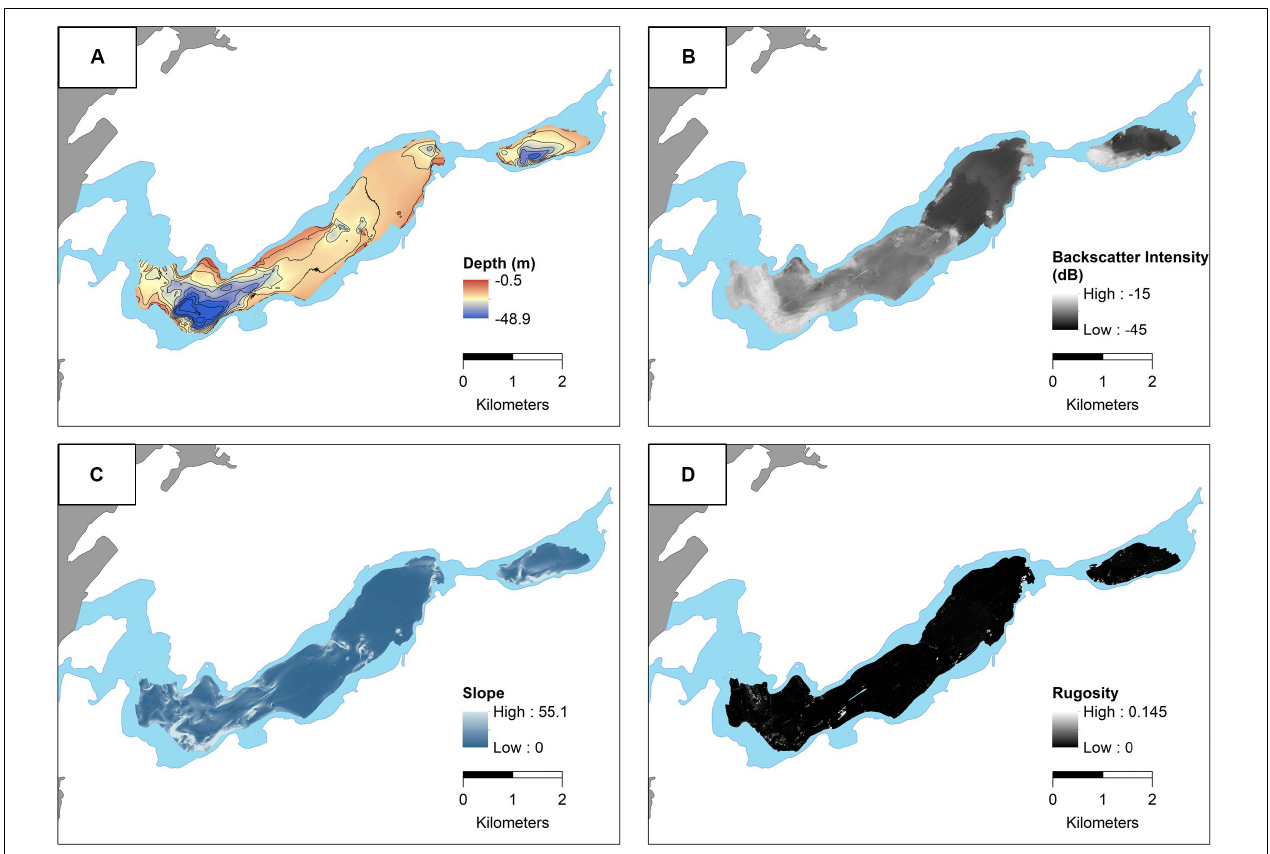
FIGURE 2 | Results from the 2017 Kongsberg EM3002D MBES survey of Loch Creran showing (A) bathymetry data (corrected to Lowest Astronomical Tide), and (B) backscatter intensity (dB); (C) slope and (D) rugosity were derived from the bathymetry data during data processing. The rasters shown have been merged and resampled to 2 m resolution. Prior to classification using Iso-cluster, the data were normalised to a scale between 0 and